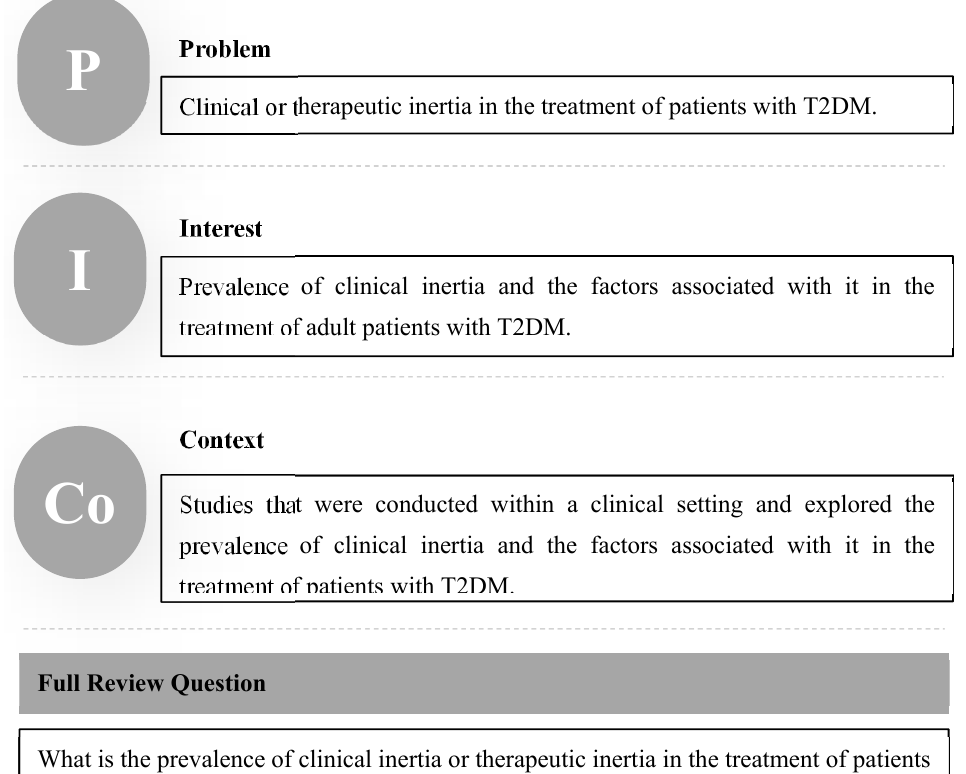
Figure 1. PICo elements (PICo framework) .